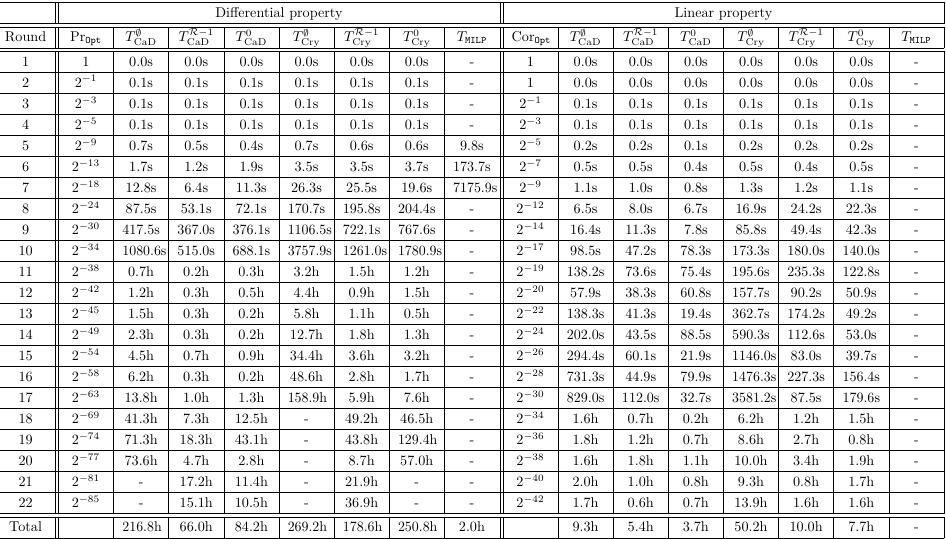
Table 17: Experimental results of SPECK32 .